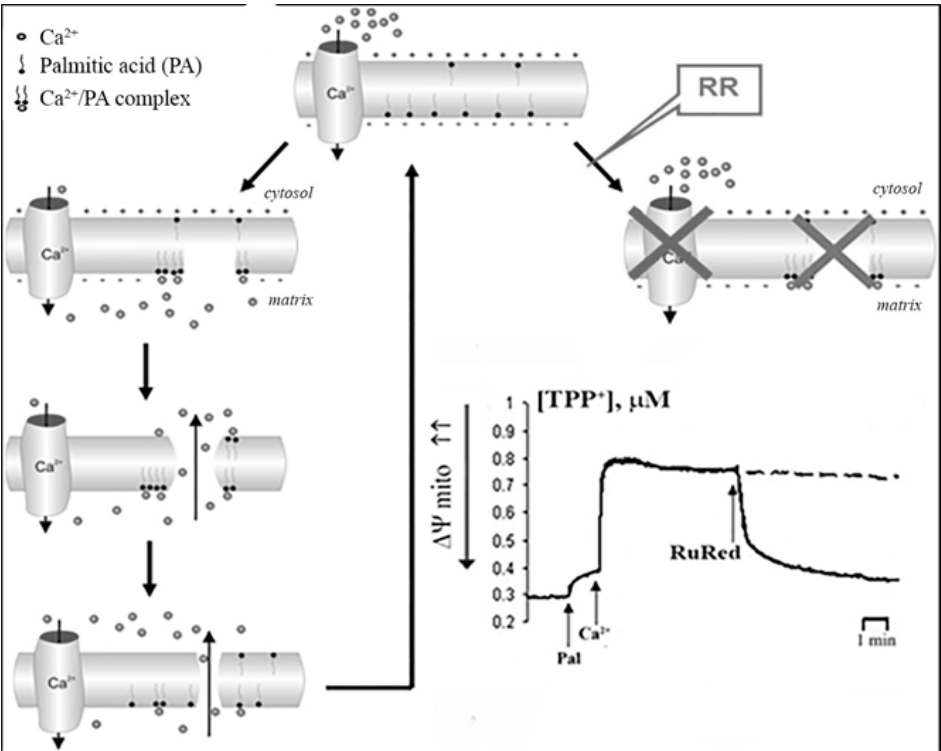
Figure 5. A possible mechanism о f PA-mPT pore formation upon the activation of phospholipase А 2 .